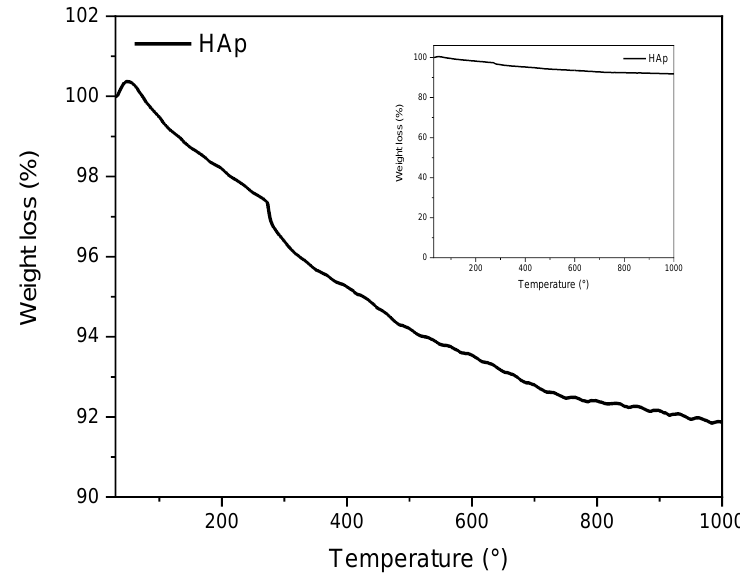
Figure 3. TGA thermogram of the synthesized HAp.